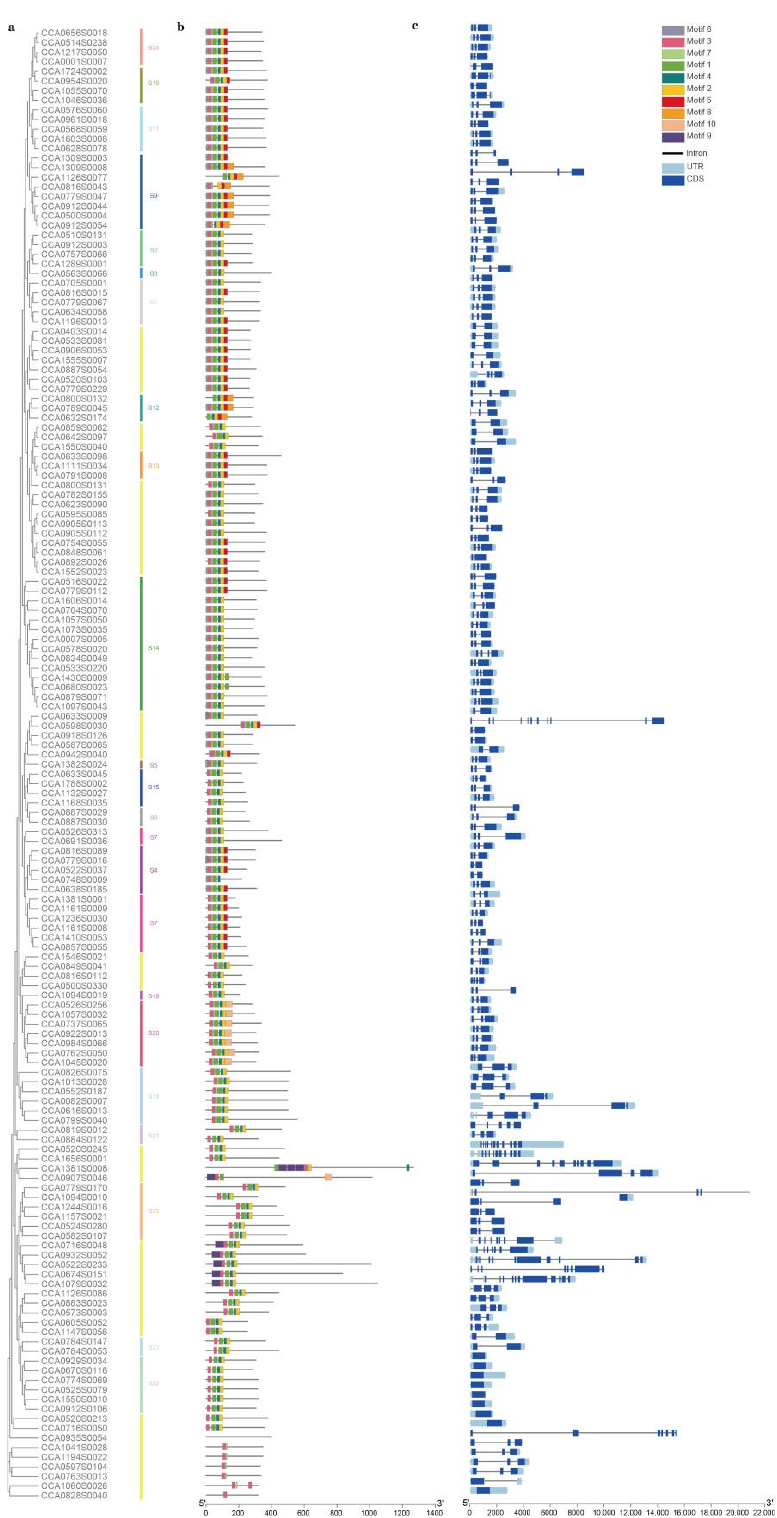
Figure 2. Phylogenetic analysis, protein conservative motifs, and gene structure of R2R3-MYB family genes in Carya cathayensis . ( a ) Phylogenetic trees were established according to full-length aa sequence alignment of 153 R2R3-MYBs in Carya cathayensis . Solid-colored vertical lines indicate 23 subgroups. ( b ) Schematic of protein conservative motifs. Solid colored boxes represent protein motifs. ( c ) Gene structure display of R2R3-MYB family genes in Carya cathayensis . Solid black line and blue box indicate introns and exons,